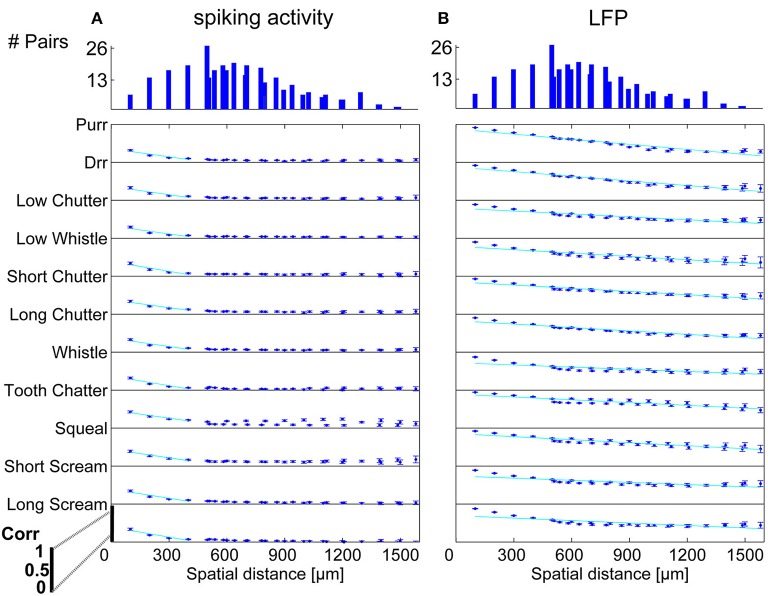
Correlation dependence on spatial distance for differently frequency-tuned neurons. Averaged correlations values for each distance from one recording set are displayed for all vocalizations, for (A) spiking activity, and (B) Local field potentials. Correlations decrease almost linearly with spatial distance, with a much bigger decrease for spiking activity than for LFPs. Exponential regression of this decrease (–), with overlaps of 61–100%, see Table 1. On top, the number of multi-unit pairs for each spatial distance over which the average correlation was computed is displayed. The y-axis for each vocalization shows a correlation range of 0–1.